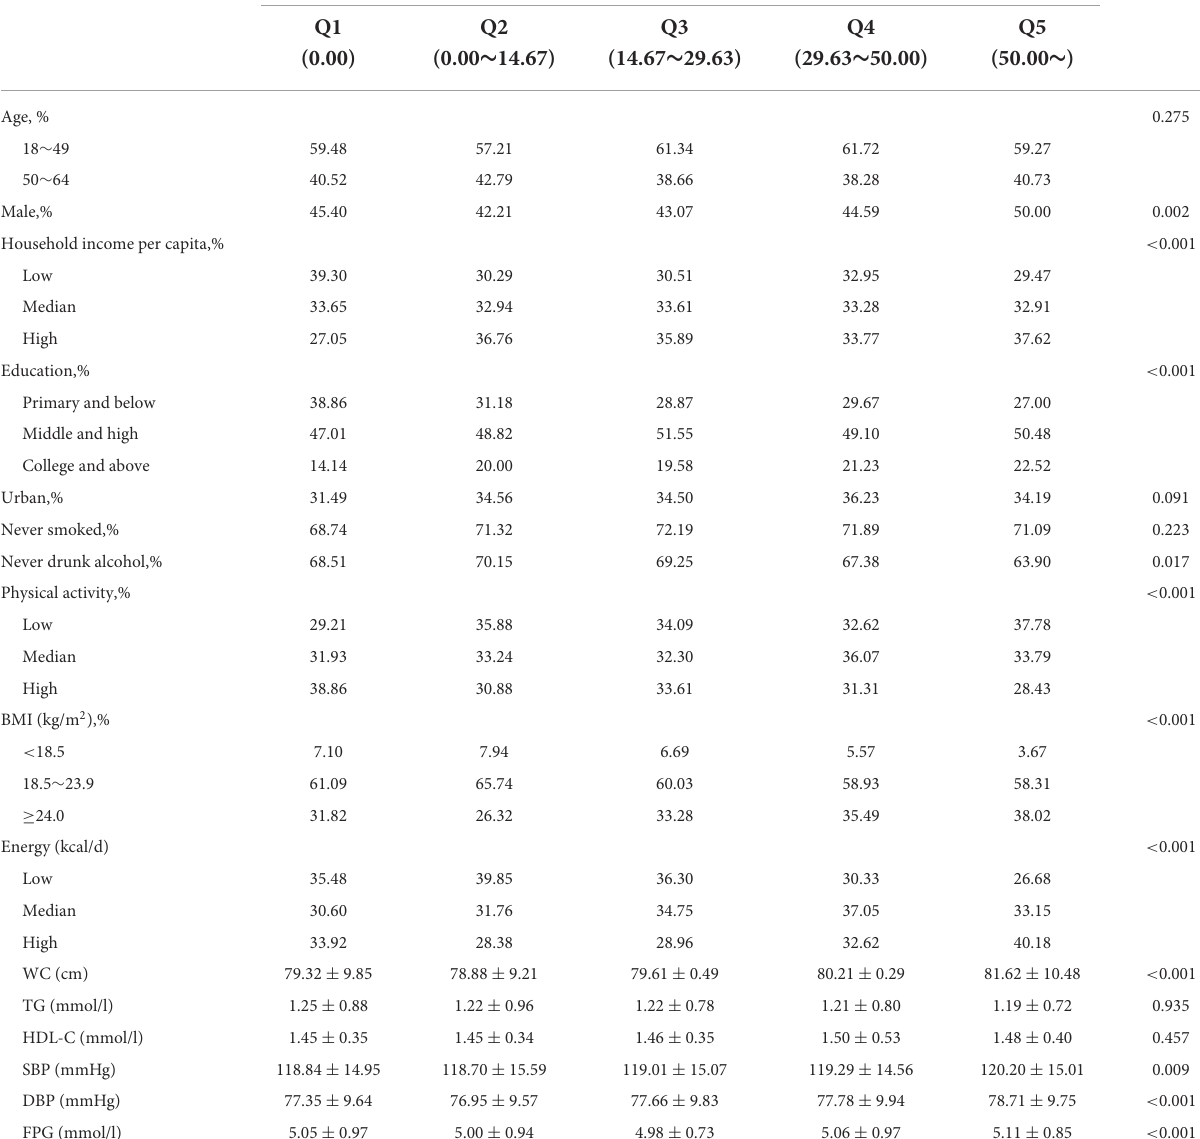
TABLE 1 Characteristics of participants according to quintile of egg